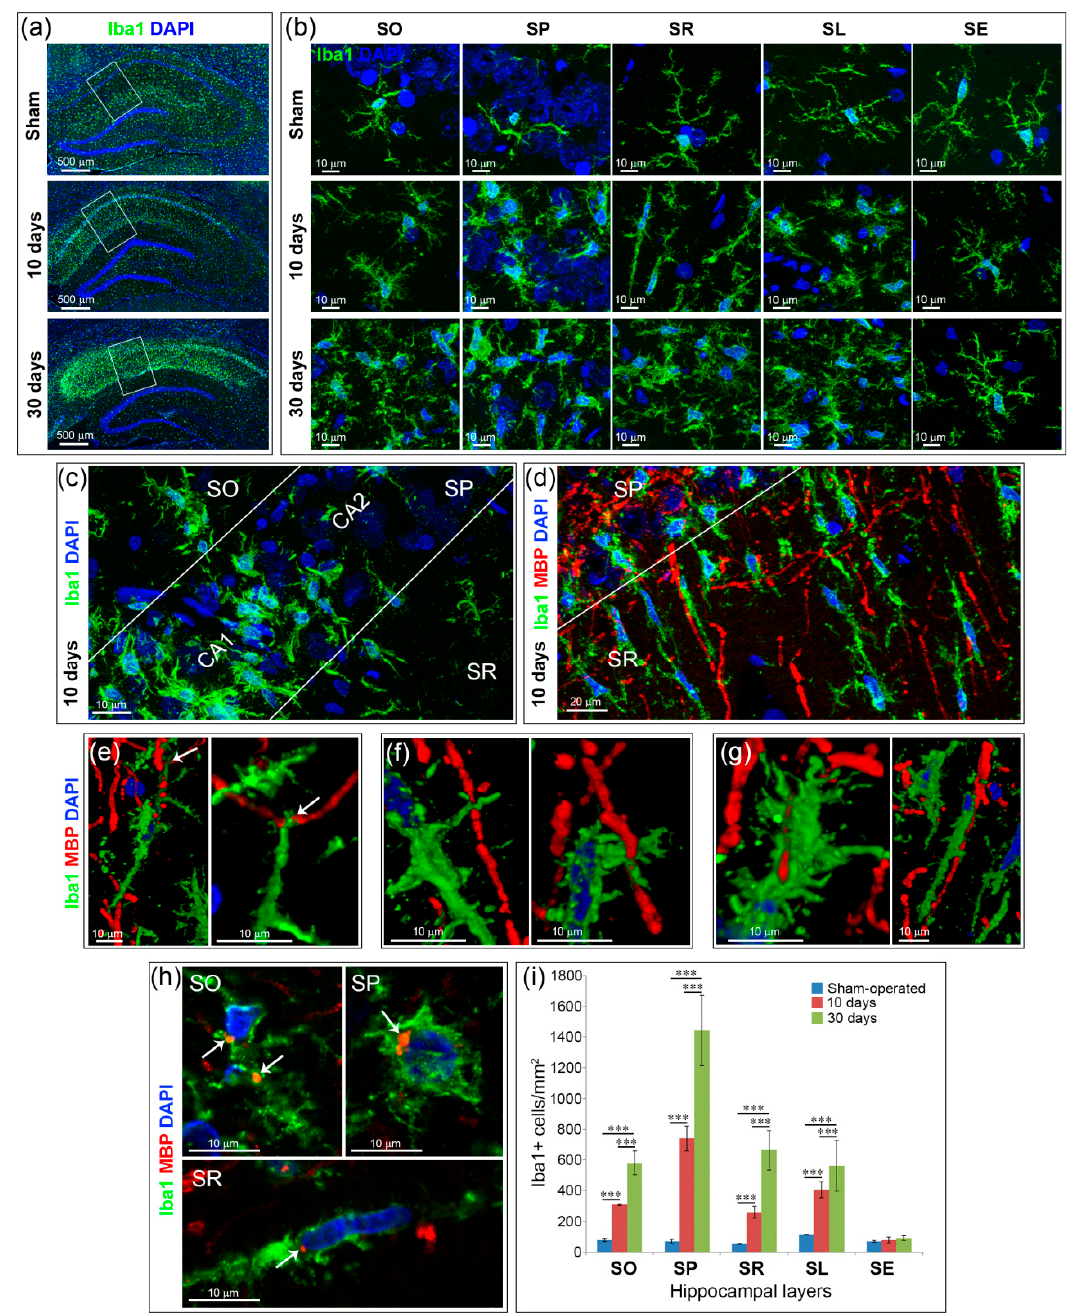
Figure 2. Microglia / macrophages (Iba1 + calls) in the hippocampal layers at the CA1 field level in rats after GCI (10 and 30 days) and the sham-operated animals. ( a ) General views of the hippocampus. The white line marks the area within the hippocampus where the cells with characteristic morphology of each layer were selected, 20× objective; ( b ) representative views of the morphology of Iba1+ cells in the hippocampal layers. Images taken from a series of optical slices using maximum intensity projection (MIP) of the z-stack; ( c ) CA1 and CA2 fields within the stratum pyramidale (SP) layer sharply differ in the number and immunoreactivity of Iba+ cells. The MIP image; ( d ) Fragment of field CA1 with rod-shaped microglia in stratum radiatum (SR); ( e – g ) types of interaction of Iba1+ cells with myelinated fibers in the SR, 10 days after GCI. 3D reconstruction of z-stacks. White arrows in ( e ) (left—general plan, right—enlarged fragment) indicate the place of contact of Iba1 + cells with myelinated axon; ( h ) myelin basic protein (MBP)-positive material (white arrows) is utilized by Iba1 + cells in the stratum oriens (SO), stratum pyramidale (SP) and substratum radiatum (SR); ( b – h ) 40× oil immersion objective; ( i ) quantification of Iba1+ cells in the hippocampal layers in the